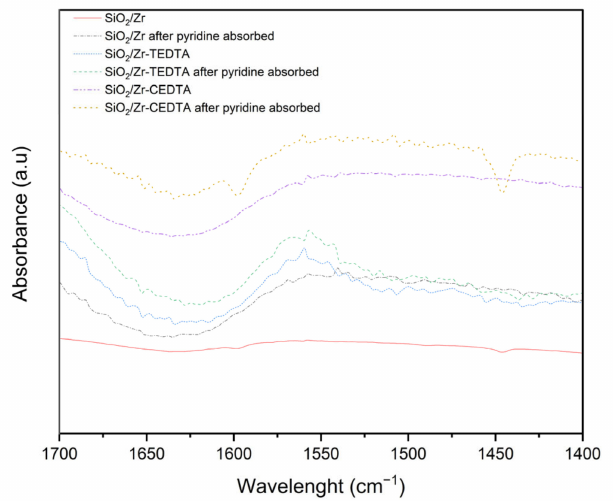
Figure 8. FTIR spectra of SiO 2 /Zr, SiO 2 /Zr-TEDTA, and SiO 2 /Zr-CEDTA before and after pyridine adsorption.